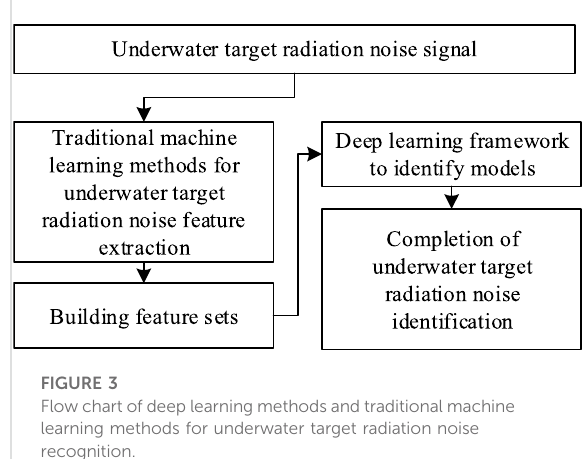
FIGURE 3 Flow chart of deep learning methods and traditional machine learning methods for underwater target radiation noise